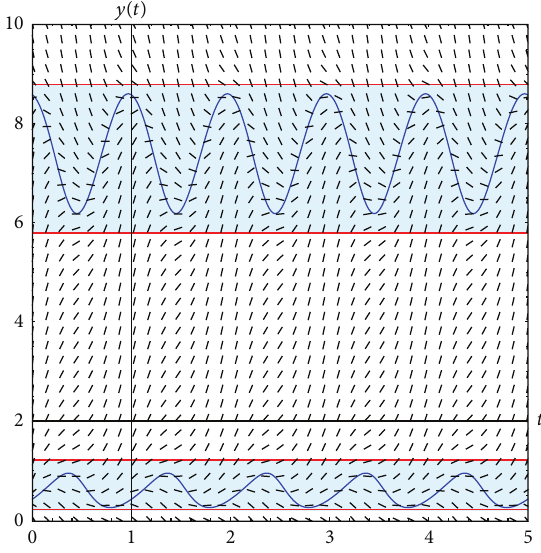
Figure 8: Nullclines and constant fences for (48) for 𝜎 =